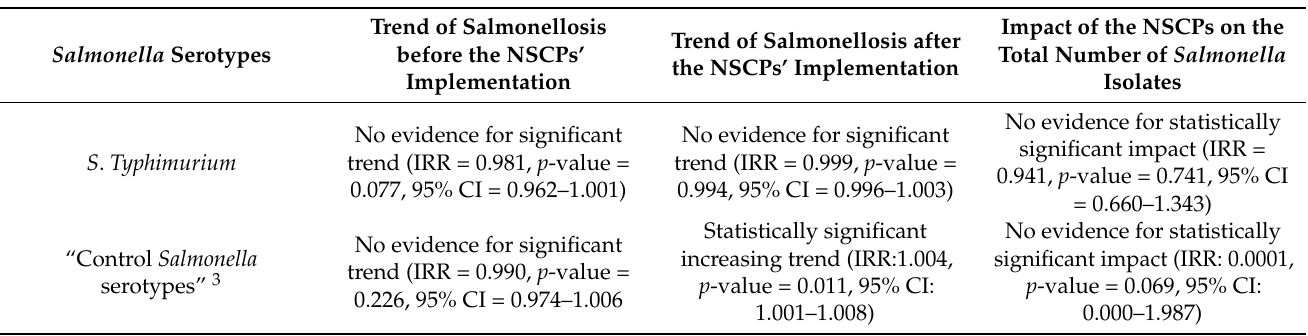
Figure 2 illustrates the distribution of Salmonella isolates due to: ( a ) S. Enteritidis (2006–2017), ( b ) S. Enteritidis (2006–2015), ( c ) S. Typhimurium , ( d ) “Control Salmonella serotypes” over time and the predicted number of isolates based to the model used.